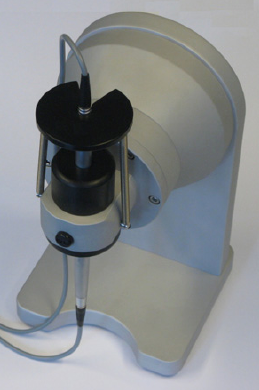
Fig. 14. Infrasound calibration Unit with built-in sound source. The unit and its associated measurement system work from 250 Hz down to 0.1 Hz and can calibrate its own reference microphones as well as working standard microphones. They may be exposed only on the diaphragm or on both diaphragm and static pressure equalization vent.